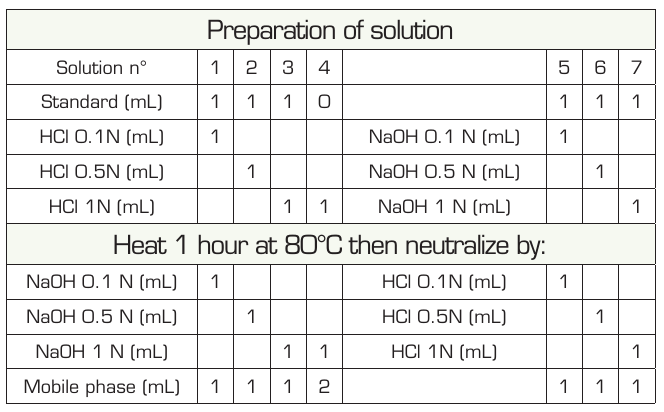
Table 5: Proposed method of forced degradation by acid, base and heat These tests will be performed on standard solutions to assess the degradation specific to the active